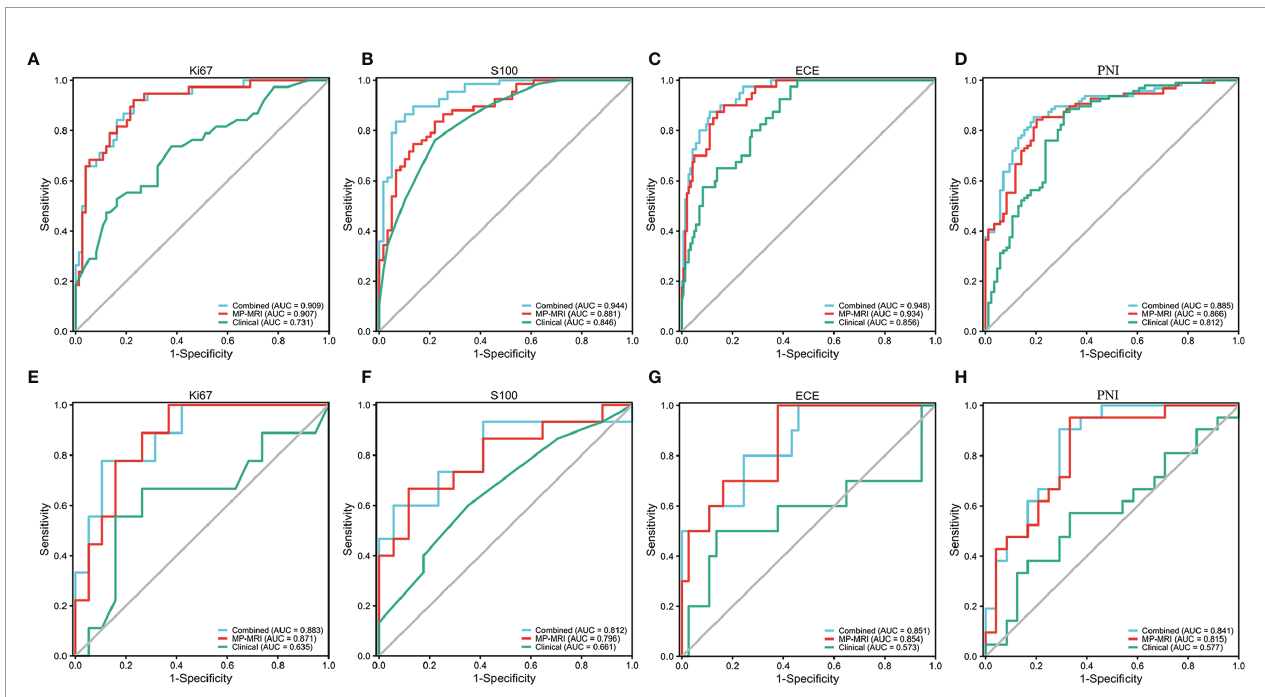
FIGURE 4 | The ROC curves of the MP-MRI, clinical and combined models in the training cohort (A – D) and validation cohort (E – H)